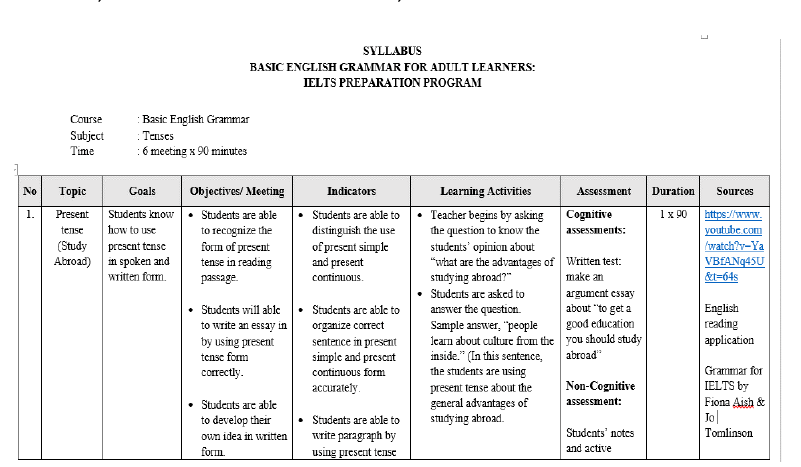
Figure 2: Syllabus of One of the Present Tense